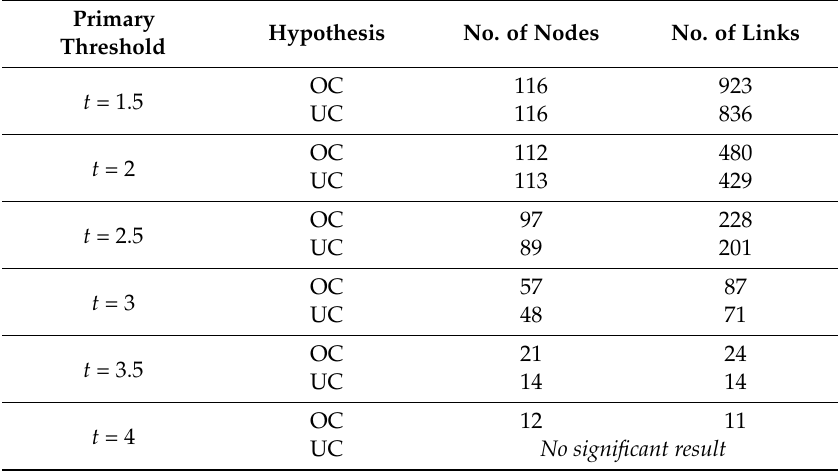
Table 4. Number of nodes and links of the subnetwork obtained under the hypothesis of overconnectivity (OC) in ASD patients and underconnectivity (UC) in ASD patients, under different primary thresholds in NBS test. In all the significant cases, the p -value was lower than